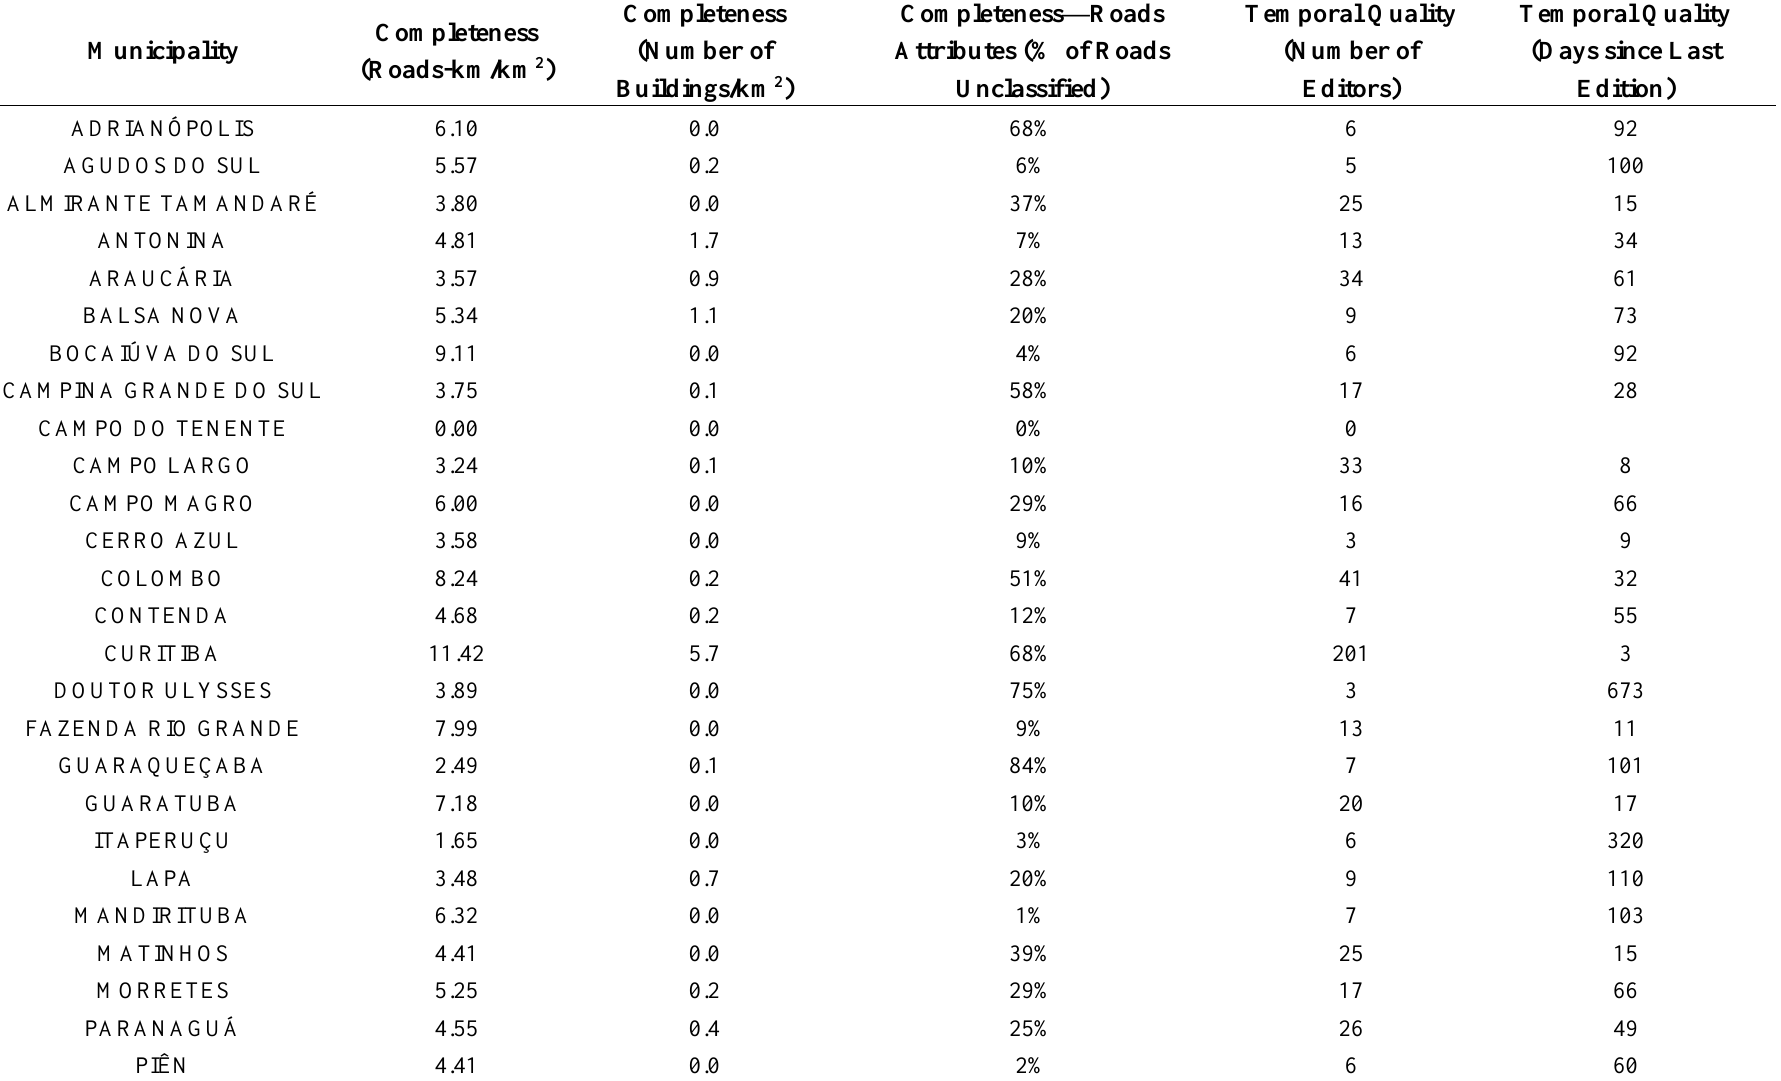
Table 4. Urban data quality